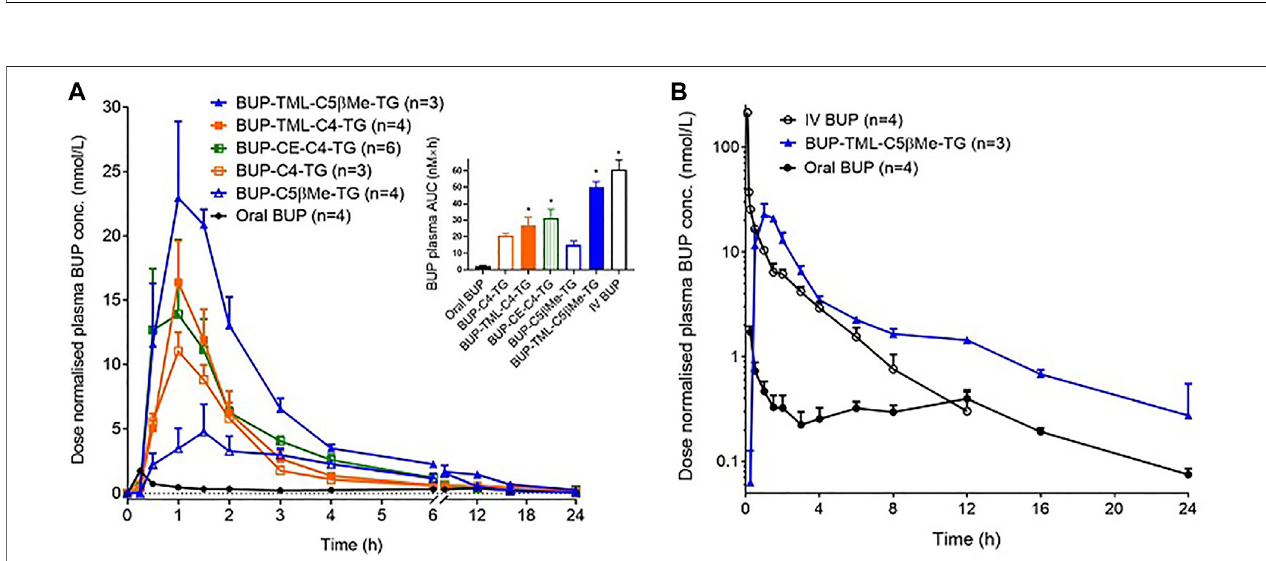
FIGURE 6 | Dose-normalised BUP plasma concentrations following oral gavage (A) or intravenous infusion over 5 min (B) of formulations to conscious, carotid artery cannulated rats (the data for oral BUP and oral BUP-TML-C5bMe-TG are replicated in Panel B for comparison to IV dosing). Oral formulations contained 20 µg of BUP or 50 µg of BUP prodrugs dispersed in 40 mg oleic acid, 25 mg Tween 80 and 2 ml PBS. The IV formulation contained 10 µg of BUP dissolved in 0.5 ml PBS. Dosesare normalized to a0.06 mg/kg equivalent dose ofBUP. Dataare presented asMean ± SEM ( n = 3 – 6, as labelled for individual groups). The embedded bar chart in (A) shows the plasma AUC values (AUC 0-inf for IV BUP, and AUC 0 – 6h for other groups), and * indicates the value is statistically signi fi cantly higher than oral BUP group ( p < 0.05).